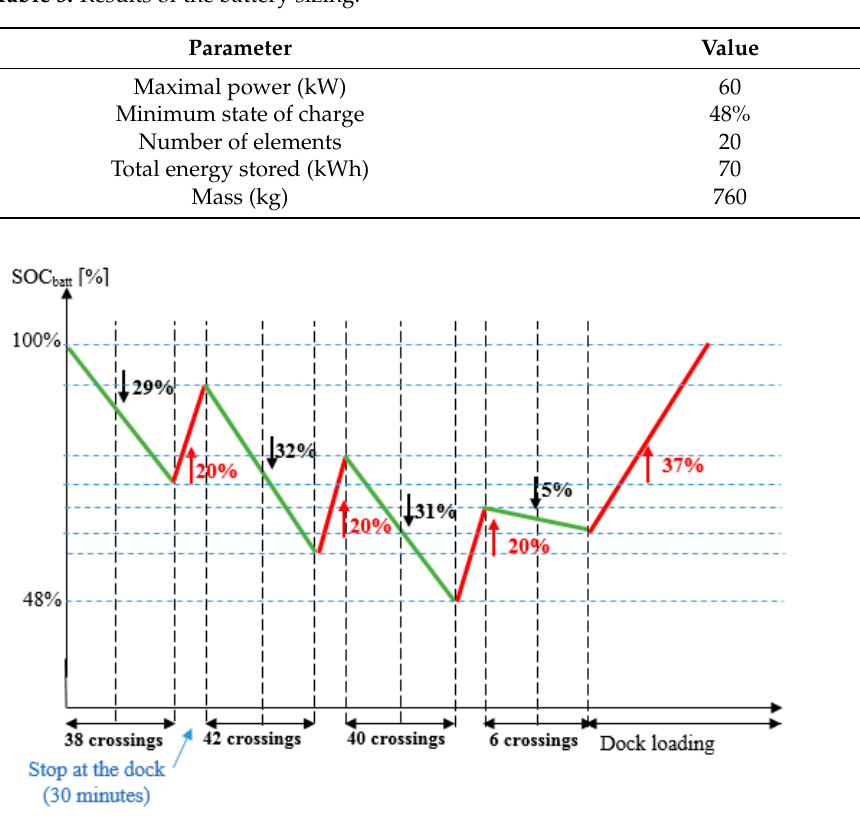
Figure 9. Battery recharging strategy for the batteries based on case.